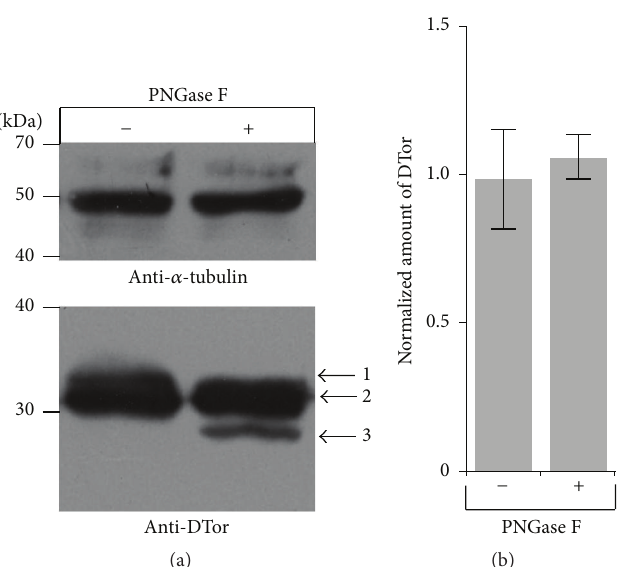
Figure 2: DTor is an N-glycosylated protein. (a) When protein extracts from w1118 were treated with PNGase F, the upper band indicated by arrow 1 disappeared and the lower band indicated by arrow 3 appeared. (b) The PNGase F treatment did not alter the overall amount of DTor protein.